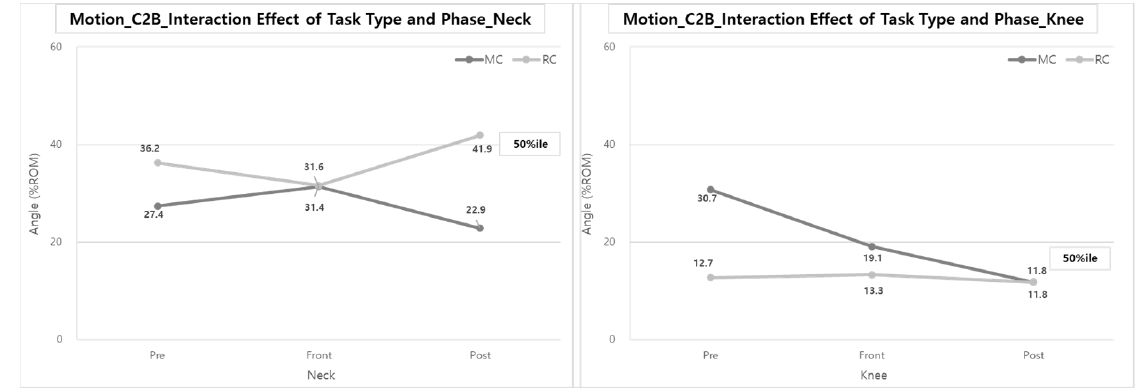
Figure 17. Interaction effect of task type and phase on the ROM of the Neck & Knee (C2B).